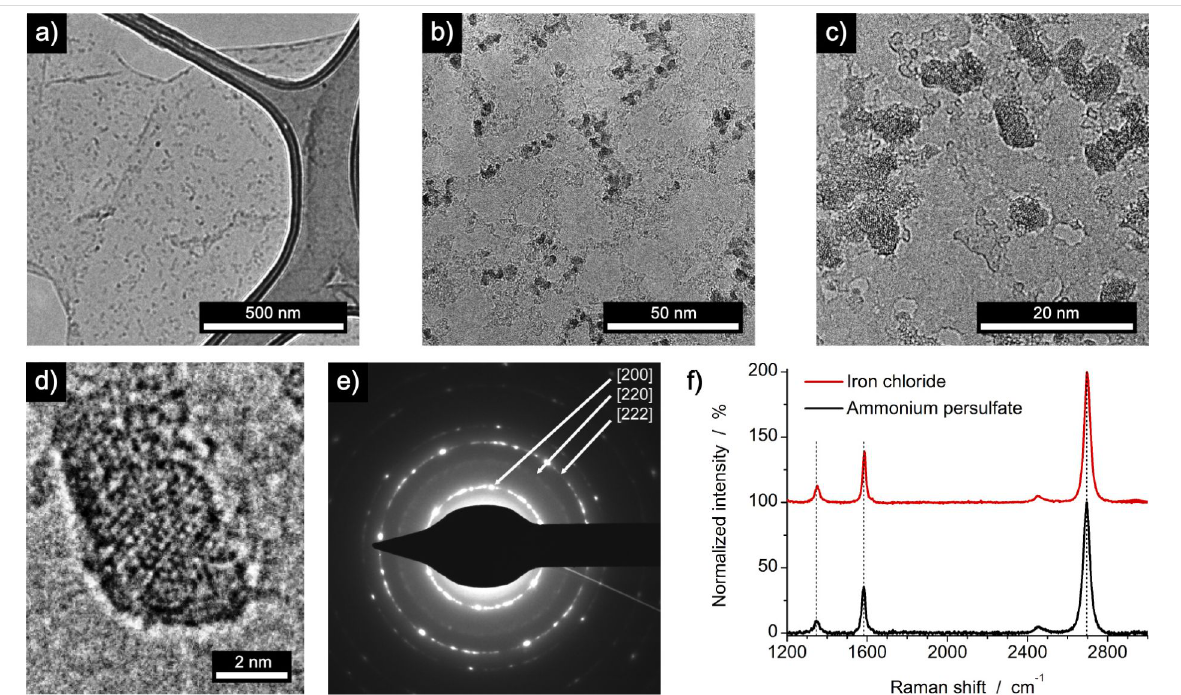
Figure 2: Characterization of CVD graphene transferred onto a TEM grid and a SiO 2 /Si wafer by the modified etching process. The etchant was 1 M iron(III) chloride in 10% hydrochloric acid solution. a–d) TEM micrographs of graphene with deposited crystalline iron oxide nanoparticles. e) SAED of cubic iron oxide Fe 0.942 O nanoparticles on graphene. f) Raman spectra of graphene after the transfer process with an aqueous solution of ammoni- um persulfate (black trace) and iron(III) chloride (red trace). Spectra are normalized to the intensity of the G’ peak and show similar peak positions, shapes and intensities.